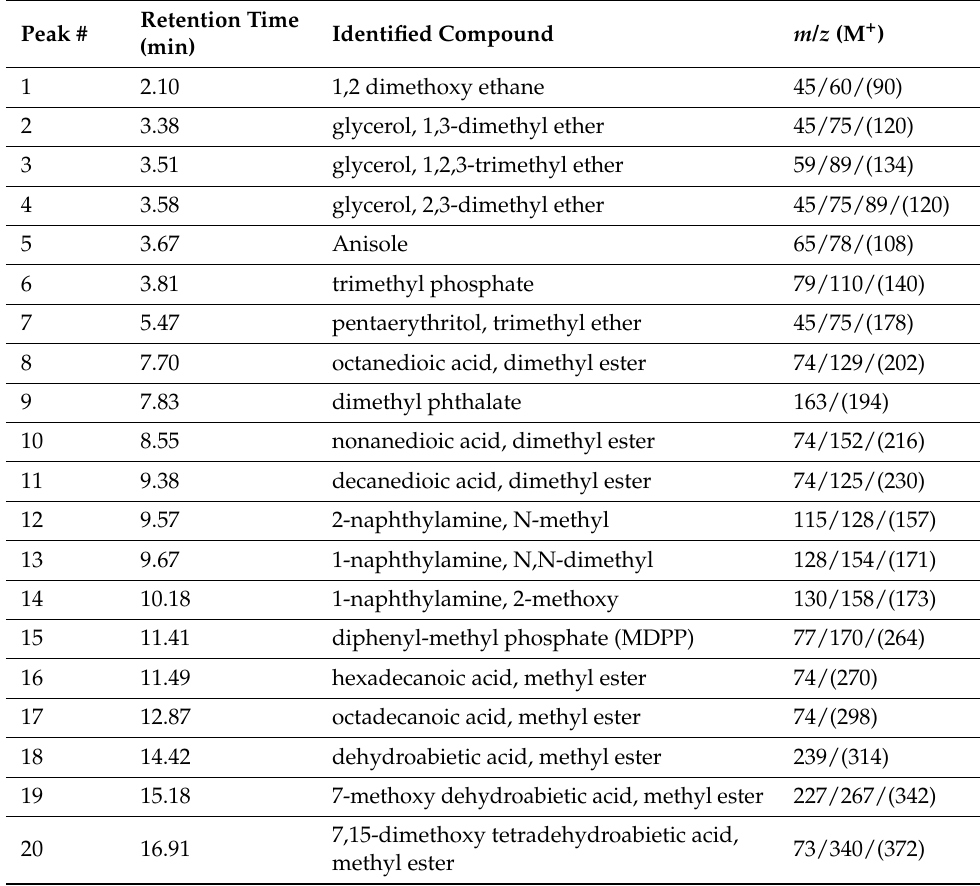
Table 3. THM-pyrolysis products identified in the red paint of cel A5a. Presented are the peak label, retention time, the identity of the compound and their typical, characteristic mass ions (AMU), the molecular ion between